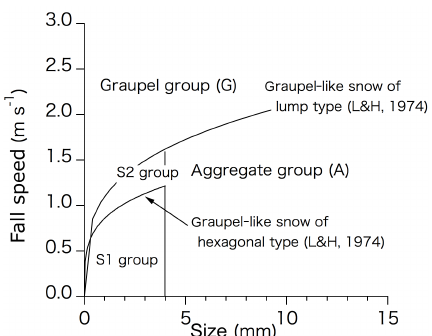
Figure 4. Categories used in snowfall event classification show- ing their location in terms of size–fall speed coordinates. The two curves represent size–fall speed relationships for lump-type grau- pel and hexagonal-type graupel (from Locatelli and Hobbs, 1974, denoted as L&H, 1974 on the